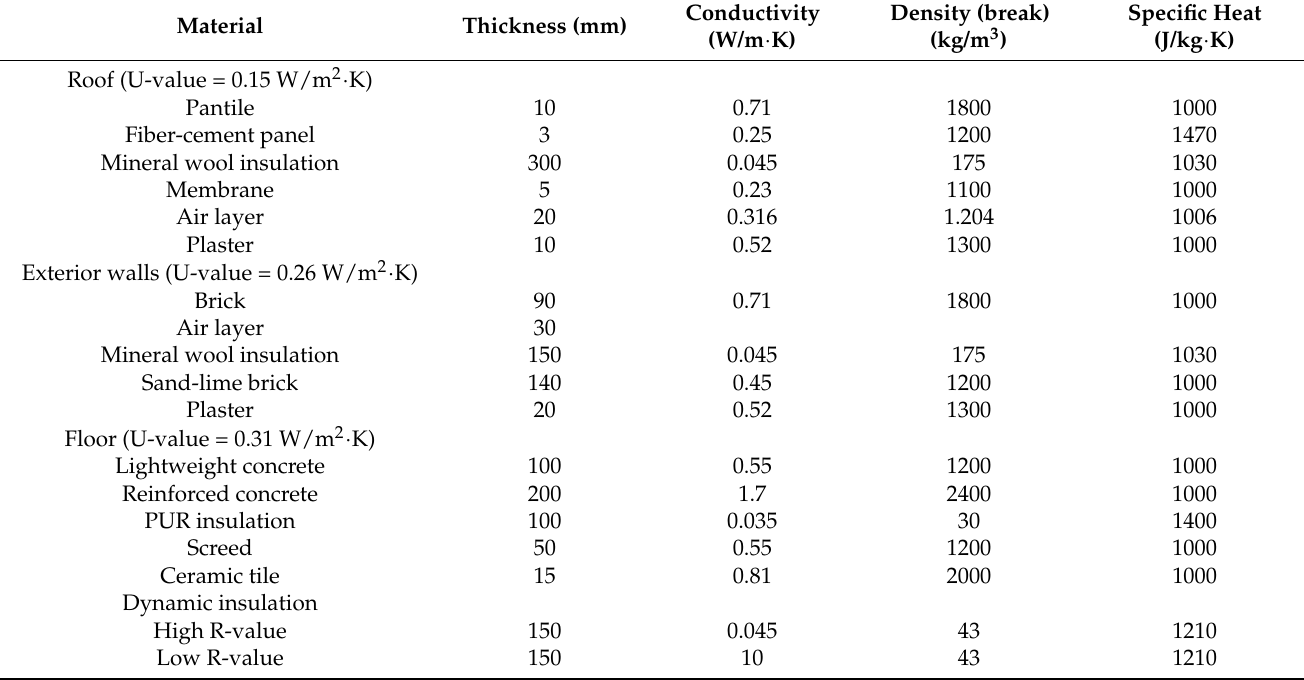
Table 3. Thermal properties for building envelope systems